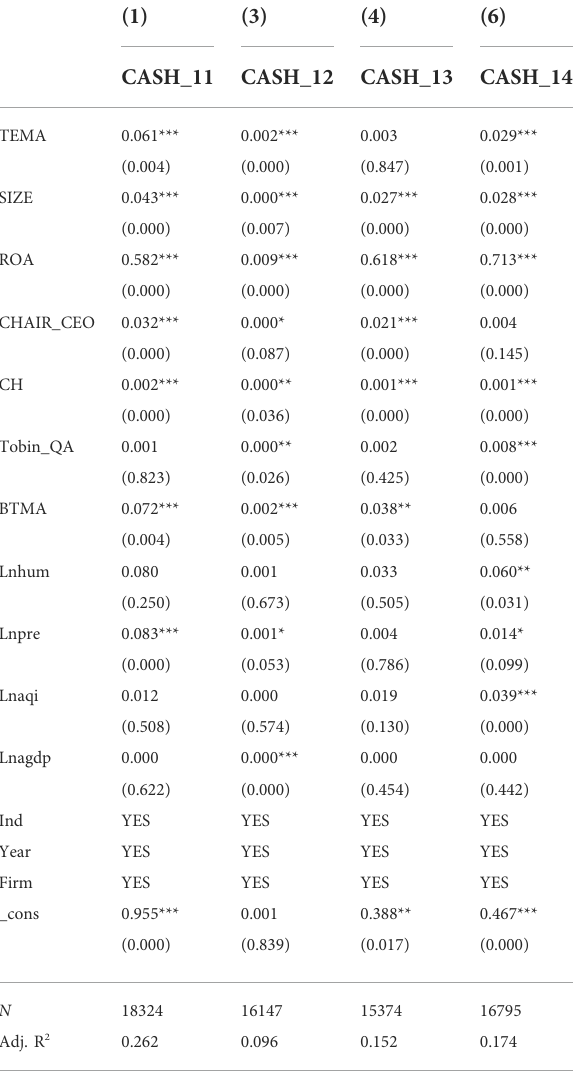
TABLE 8 Climate change and types of cash sources. TABLE 9 Test of operation risk